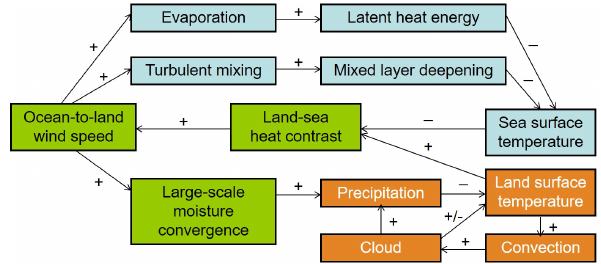
Figure 6. An air–sea feedback and interaction diagram. For each arrow, the initial status indicates that the source quantity is increas- ing, and the sign ( − or + ) indicates the changing tendency of the target quantity. Colors denote the group of changes or states over sea (blue), land (brown) and the land–sea interactions (green). Source: Ho-Hagemann et al.